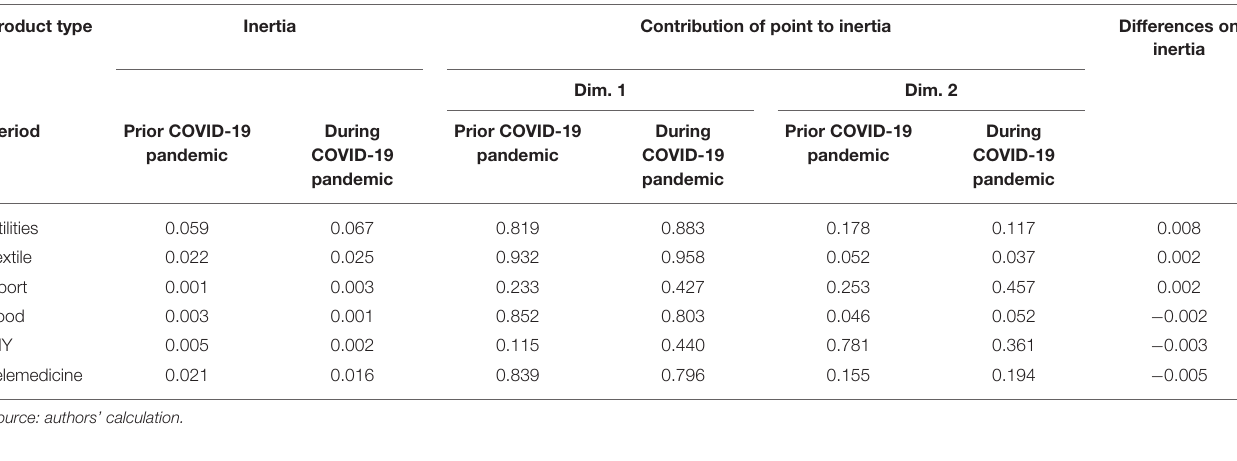
TABLE 4 | Inertia statistics on TOP 3 highest and lowest values.